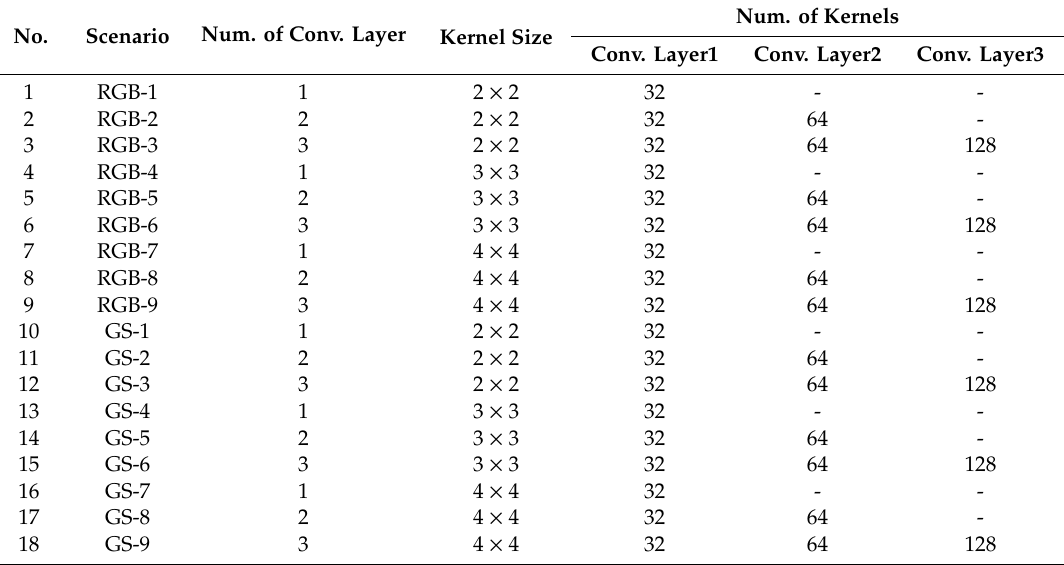
Table 3. 18 number of scenarios considering hyperparameters.